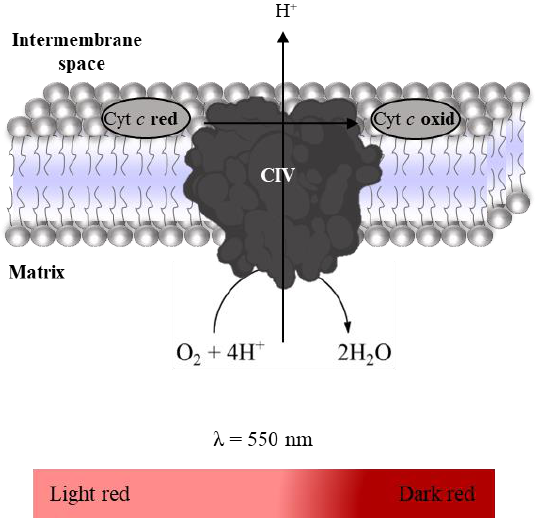
Figure 9. Oxidation of the reduced Cyt c with water production. Table 7. Conditions and flow setup for Complex IV activity assay.